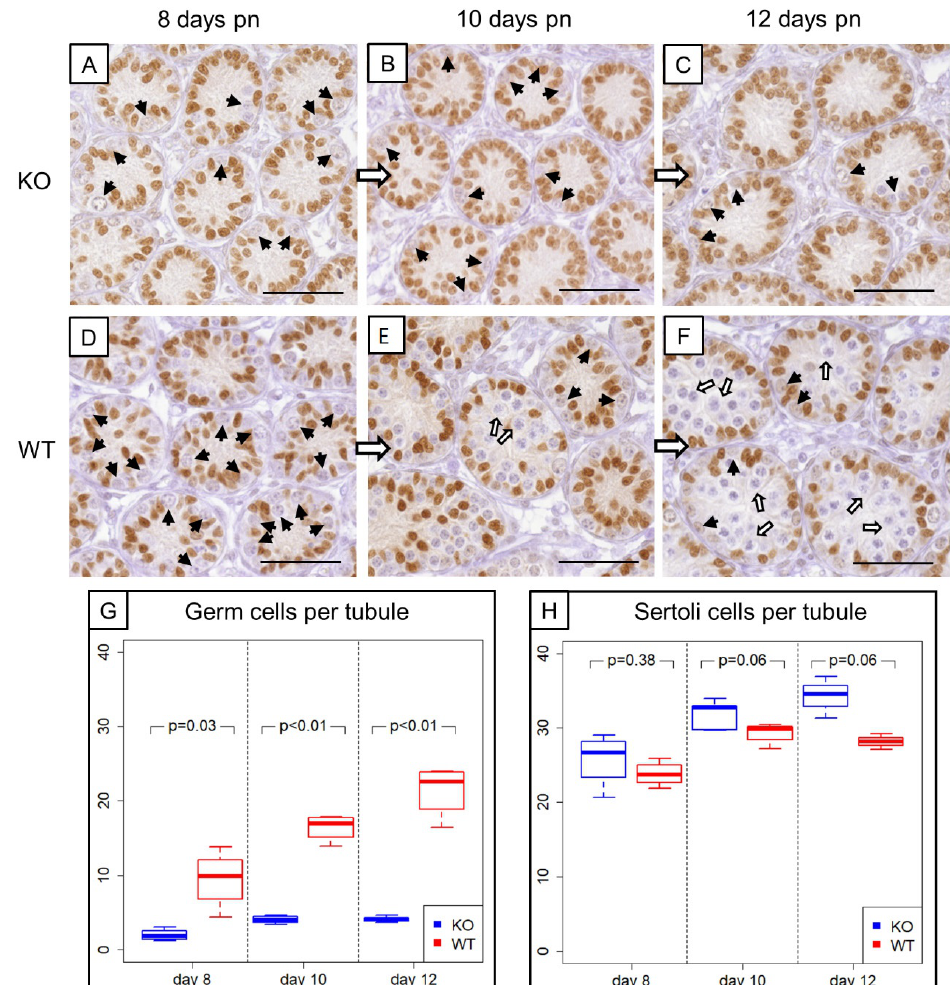
Figure 3. Comparison of prepubertal SCCx43KO mice with their WT littermates. ( A – C ) SOX9 immunohistochemistry of 8-, 10-, and 12-day-old SCCx43KO mice. Sertoli cell nuclei showed a distinct immunostaining, whereas germ cells were immunonegative (black arrows). KO mice exhibited an arrest of spermatogenesis at the level of spermatogonia. ( D – F ) Immunohistochemistry of SOX9 in 8-, 10-, and 12-day-old WT littermates. In WT mice, the first spermatocytes were detectable ten days pn (white arrows), whereas in KO mice only spermatogonia could be found. The difference became more pronounced with increasing age. Scale bars: 50 µm, numerical aperture 0.75. ( G ) Illustration of the average number of germ cells per seminiferous tubule of prepubertal KO and WT littermates ( n = 4 per age group and genotype). Note already reduced germ cell numbers in 8-day-old SCCx43KO mice compared to WT littermates. ( H ) Schematic representation of mean Sertoli cell numbers per seminiferous tubule of KO and WT mice at different ages ( n = 4 per age group and genotype). Cx43: connexin 43, KO: knockout, pn: post-natum, SCCx43KO: Sertoli cell-specific Cx43 knockout, WT: wild